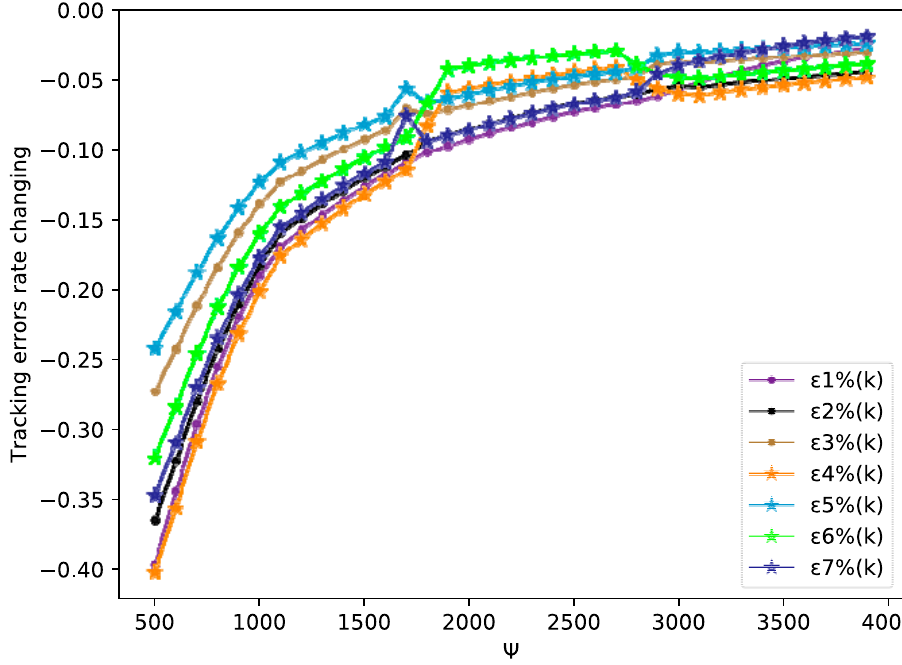
Figure 11. Tracking errors rate of each agent at Ψ ∈ [ 500,4000 ] (example